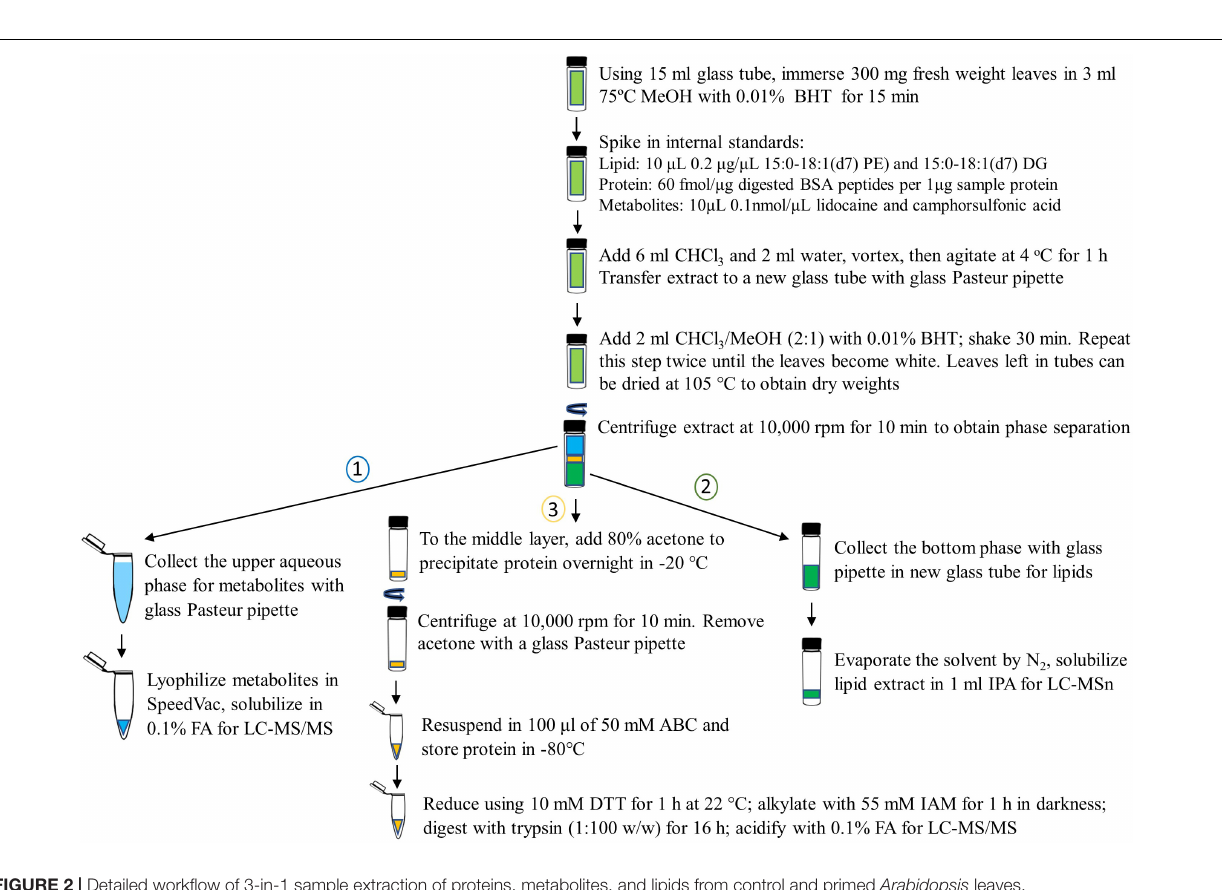
Frontiers in Genetics |